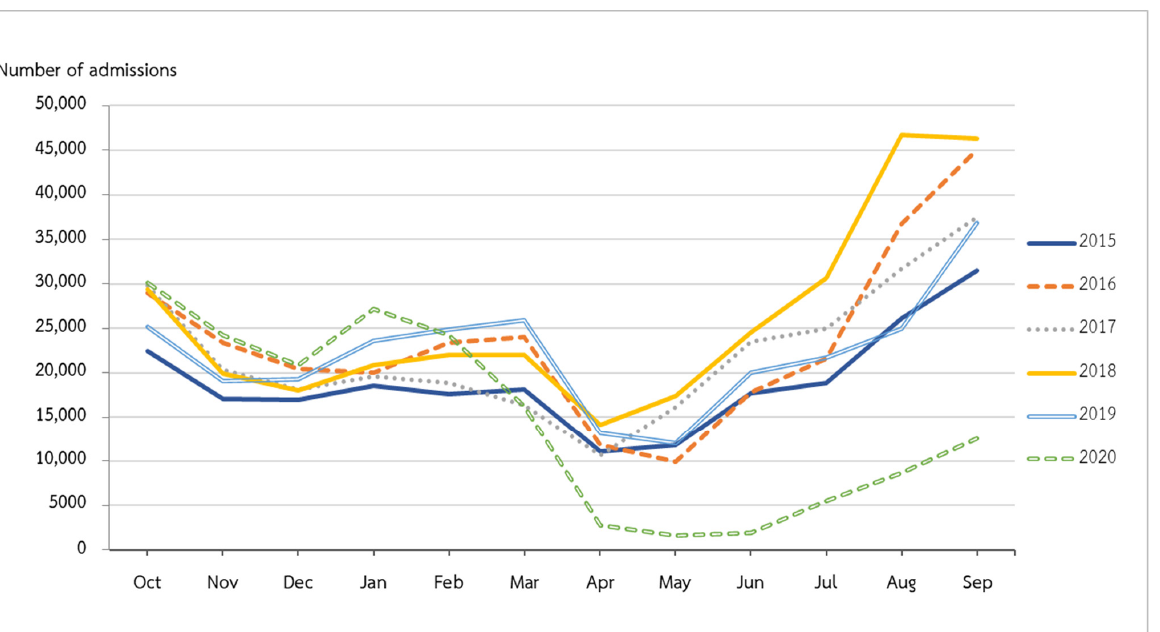
Figure 2. Number of LRTI admissions by month in fiscal year 2019 compared with 2020 in Thailand. During the COVID-19 outbreak in Thailand in the 2020 fiscal year, a total of 186,651 pediatric patients were hospitalized with lower respiratory tract infections (LRTIs). There were 120,281 pneumonia admissions (64.44%), followed by 50,333 bronchitis admissions